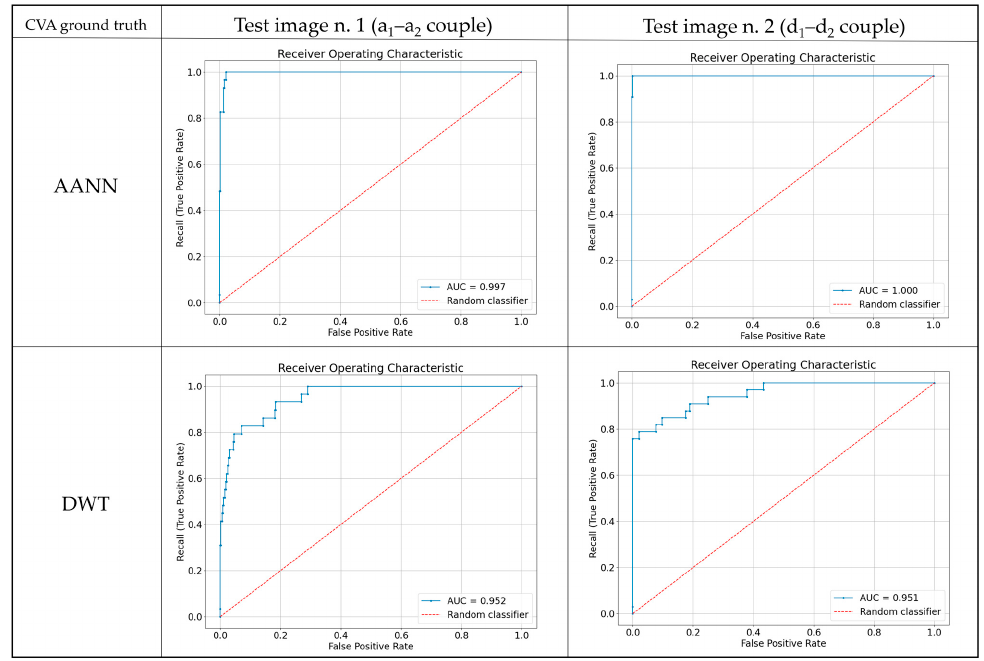
Figure 17. ROC curve for test image 1 in Figure 11(a 1 ,a 2 ) ( left ) and test image 2 in Figure 11(d 1 ,d 2 ) ( right ). CVA ground truth image.